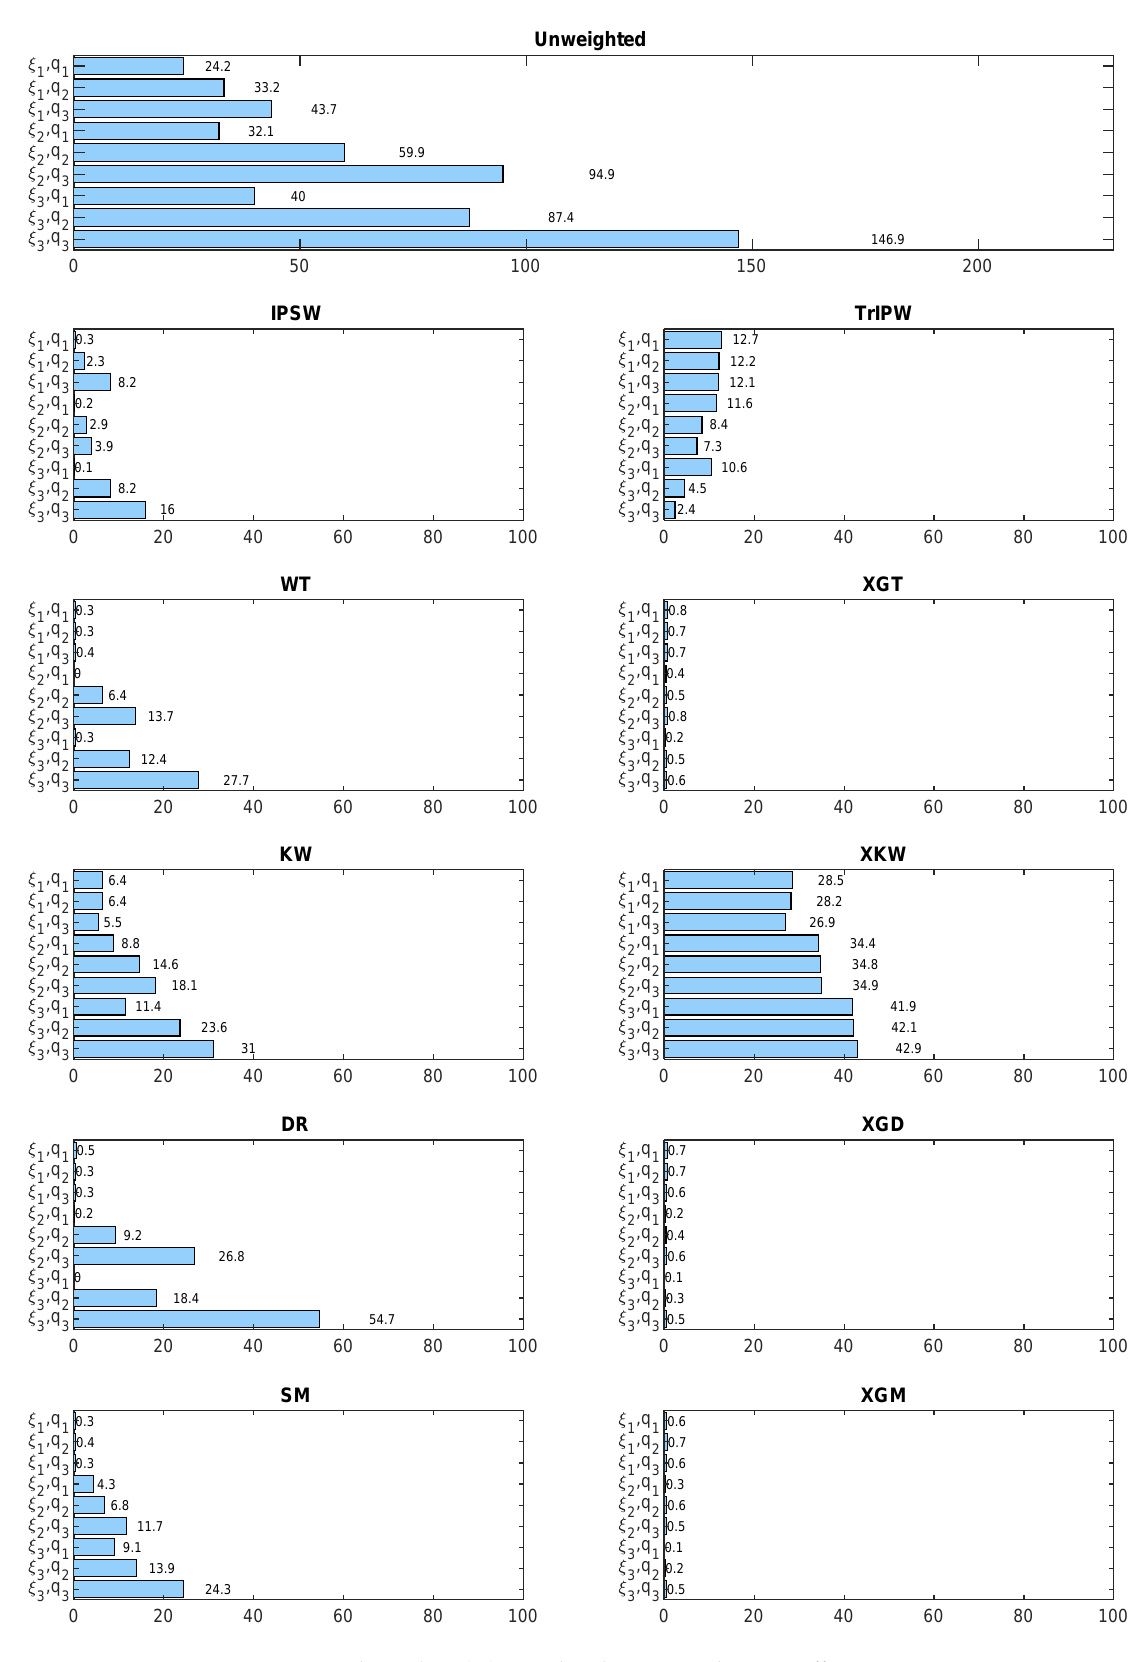
Figure 6. Relative bias (%), simulated case, correlation coefficient: